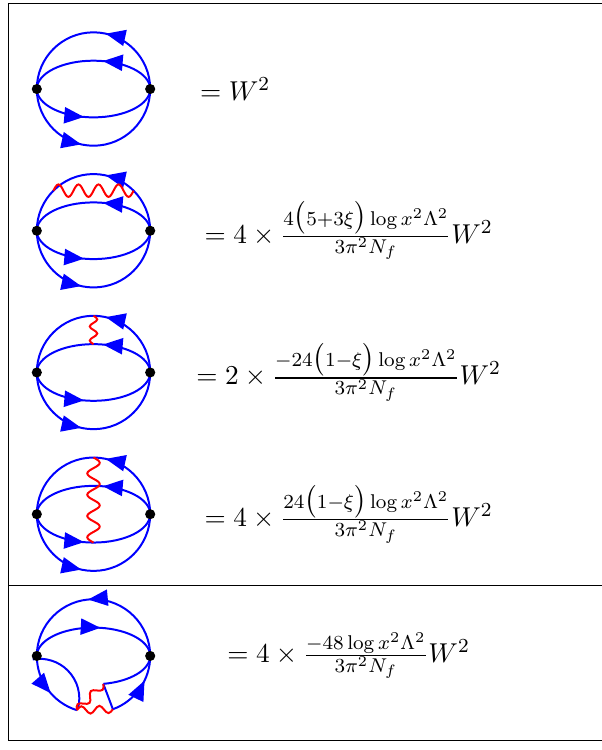
Table 3 . (bQED) adjoint-2 and adjoint quartic operator renormalization.